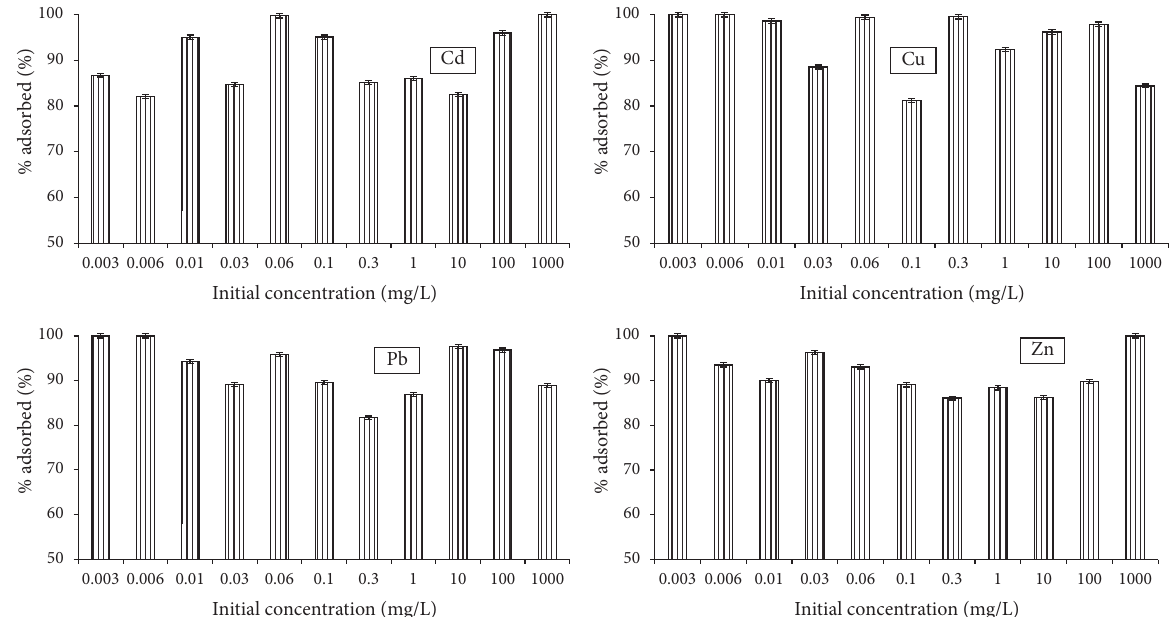
Figure 1: Amounts of metal ions adsorbed in dependence on their initial concentration in the mixture.